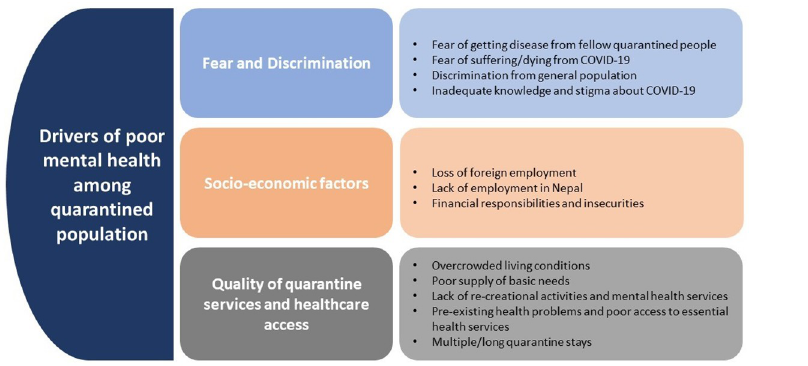
Fig 2. Summary of factors driving poor mental health in quarentine